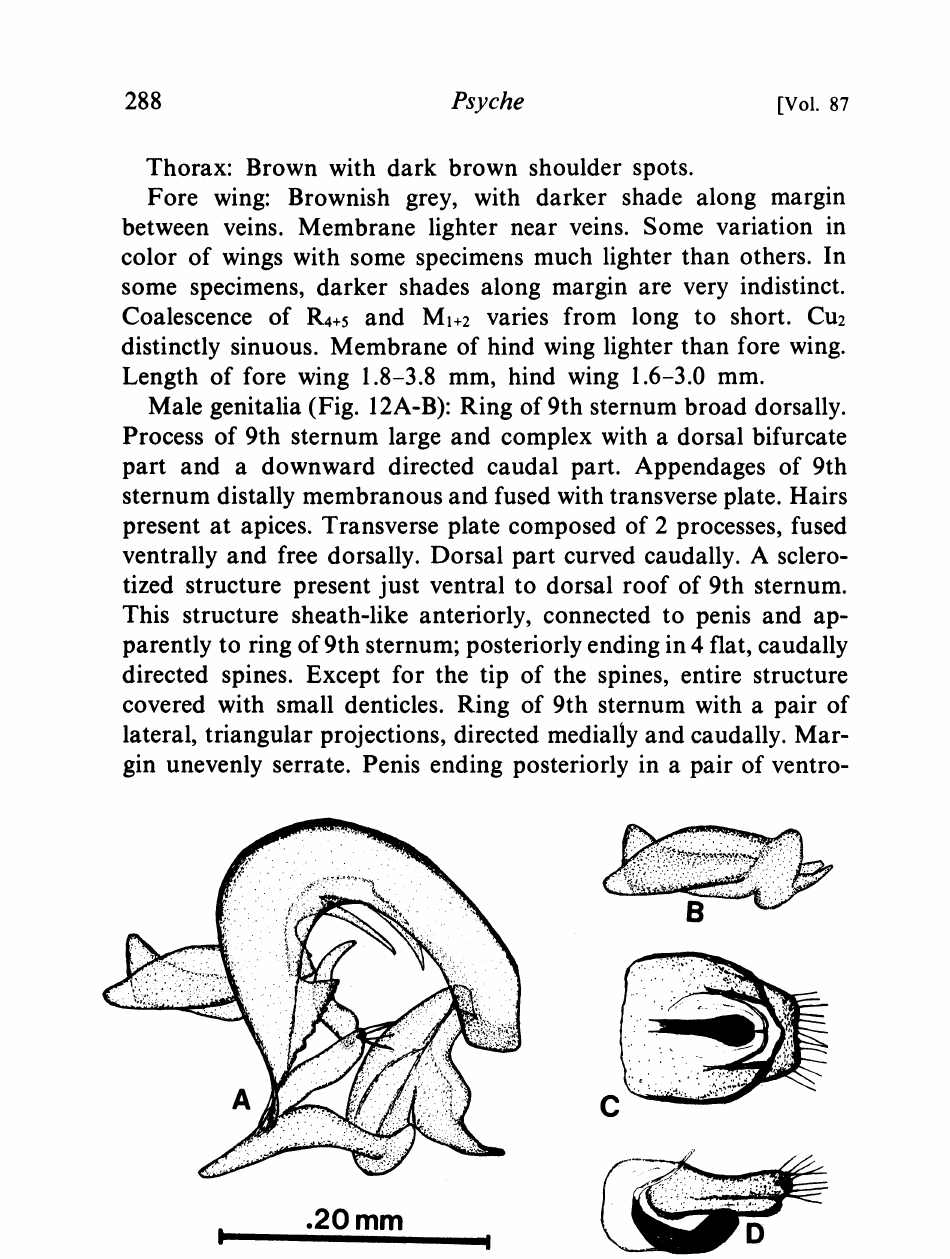
Figure 12. Aleuropteryx simillima. A. Male genitalia, lateral view. B. Penis, lateral view. C. Female genitalia, ventral view. D. Female genitalia, lateral